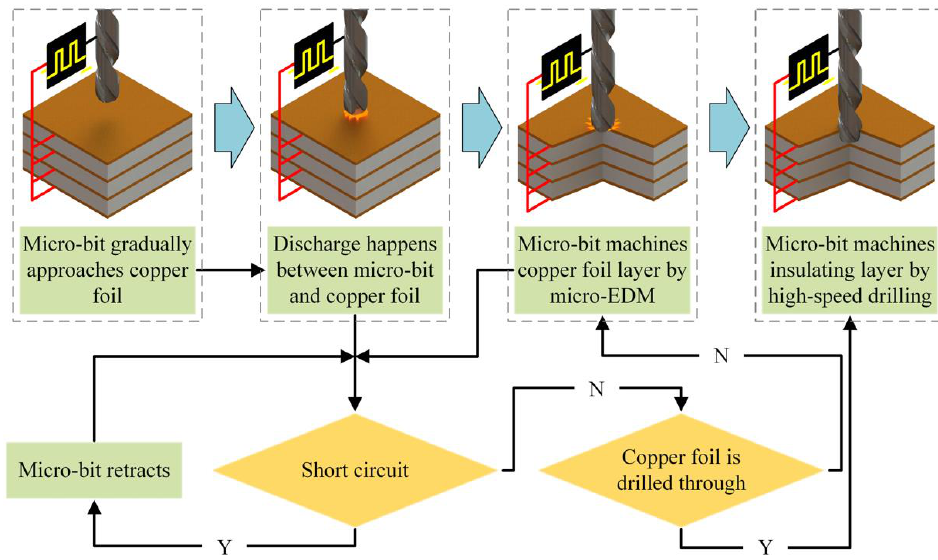
Figure 2. Specific technical process for machining PCB micro-hole by using micro electro-discharge machining (micro-EDM).